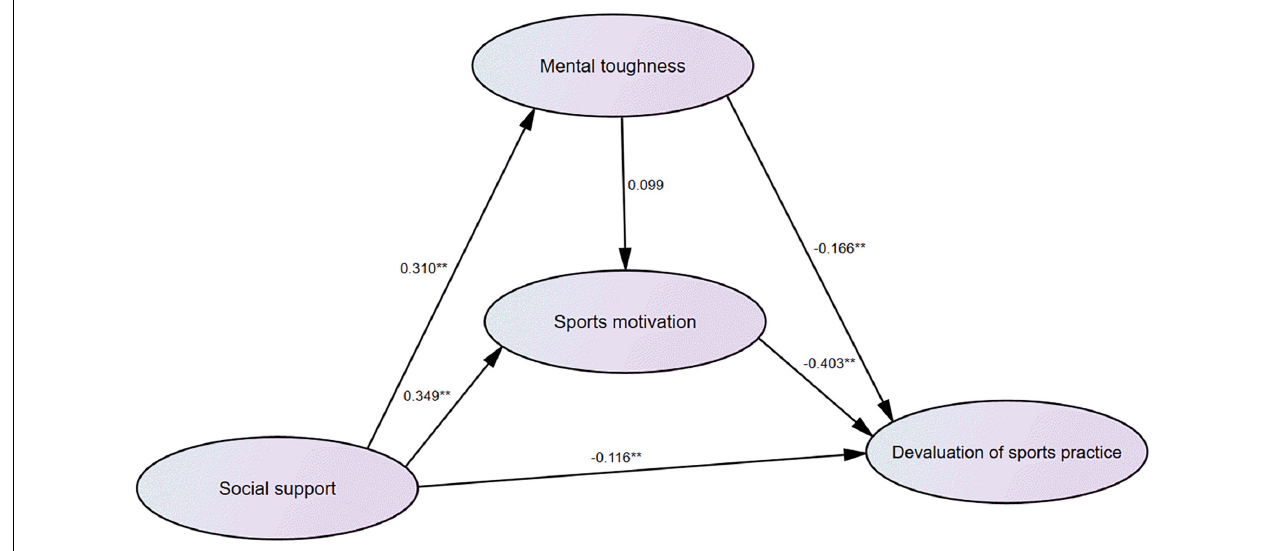
FIGURE 4 | Schematic diagram of path analysis of social support, sports motivation, mental toughness, and devaluation of sports practice. **P < 0.01.